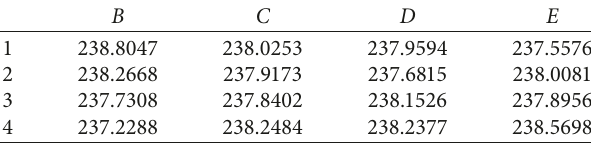
Table 16: SN ratio response table of factors B , C , D , and E .